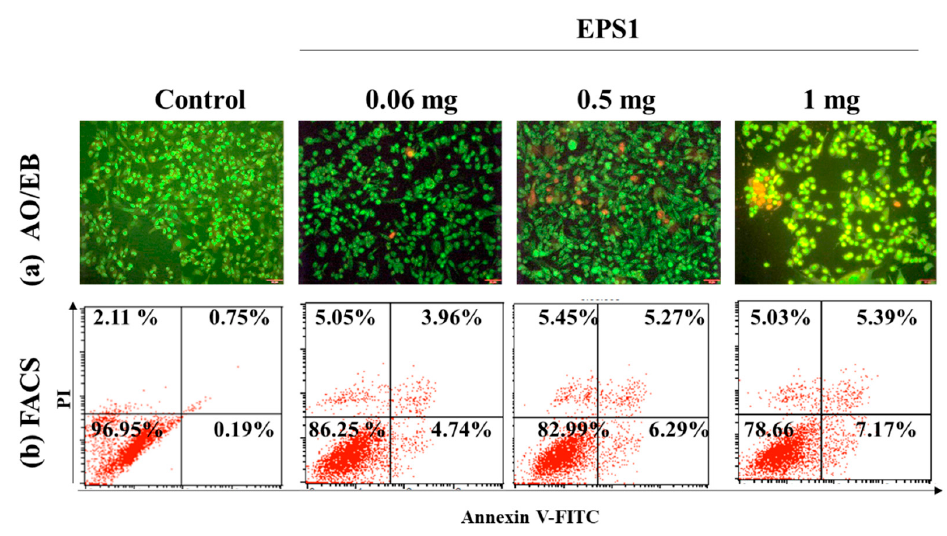
Figure 8. Effect of polysaccharides (EPS1) isolated from Trichoderma spp. on cytotoxicity in the MDA-MB231 cell line, demonstrated by AO/EB staining assay ( a ) and Annexin V-FITC- and PI staining-based FACS assay ( b ).